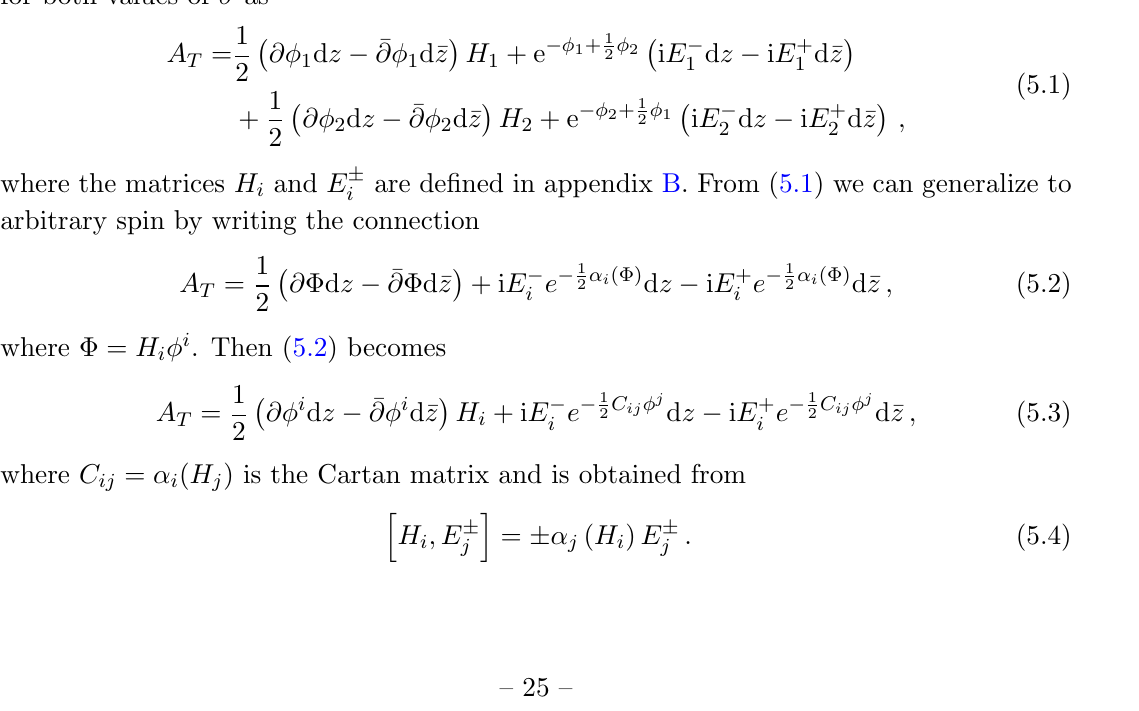
Figure 1 . The diagram represents a 10-point conformal block on a sphere . We use black legs for the external primaries inserted at points z i and their images ~ z i = 1 the exchange of the identity family. This speci(cid:12)c channel, where the mirror pairs are fused (cid:12)rst, is the one related to the monodromy problem on a disk. The green circles show contours along which the monodromy is trivial. The picture is taken from